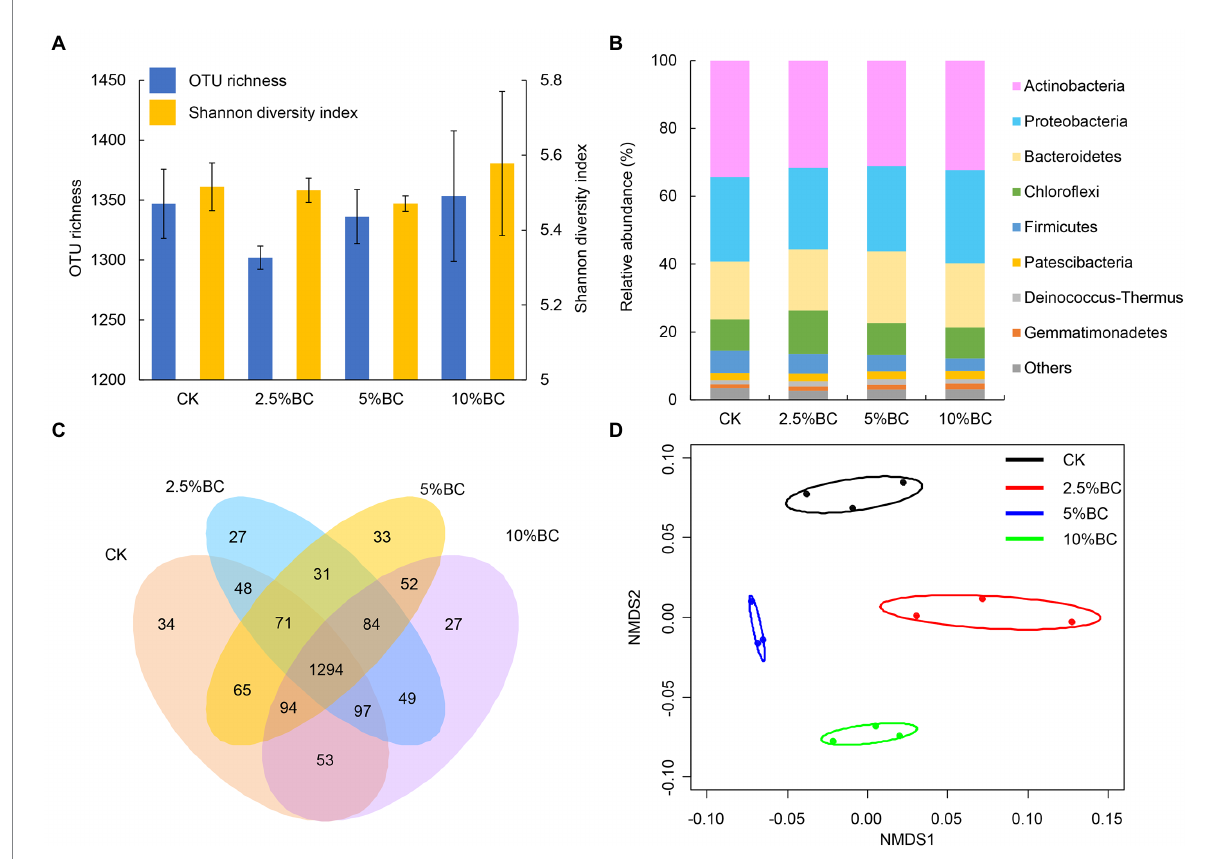
FIGURE 1 Effect of biochar on the bacterial community profiles of the compost. (A) Operational taxonomic unit (OTU) richness and Shannon diversity index. (B) Relative abundance of bacteria at phylum level. (C) Venn diagram showing the number of specific and shared OTUs in different treatments. (D) Nonmetric multidimensional scaling (NMDS) ordination plots of bacterial community composition in different treatments based on the Bray- Curtis distance similarity. The bacterial phyla represent <0.5% of the total bacterial sequences and are not identified to phylum level were all assigned to “Others.” Ellipses in the plots denote 95% confidence intervals for the centroids of different treatments. CK, compost without biochar; 2.5%BC, compost added with 2.5% (w/w) biochar; 5%BC, compost added with 5% (w/w) biochar; 10%BC, compost added with 10% (w/w)